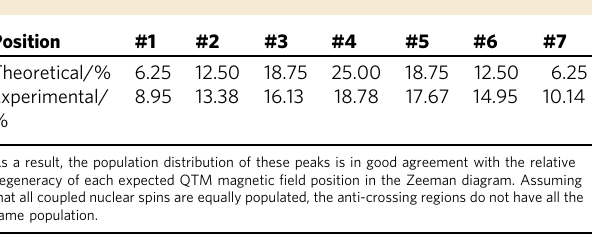
Fig. 3 Electronic read-out of the coupled spin. a Selected differential conductance traces for back-and-forth sweeps highlighting the seven expected tunnelling transitions. b Magnetic hysteresis map as a function of the applied fi eld. The gate voltage V G is fi xed and the source-drain voltage V SD is fi xed to zero. For each value B Y , the differential conductance measured during the back-and-forth magnetic fi eld sweeps are subtracted, and then plotted. Several coloured lines are observed, corresponding to the hysteresis zones of each anisotropic magnetic moment, evolving linearly as a function of the transverse fi eld. The green arrow indicates the studied region. The other regions were also studied but the nuclear spin states could not be resolved. c Histogram of the conductance jumps detected during 6000 magnetic fi eld sweeps. The panel above the Zeeman diagram shows the predicted crossings (enlarged by 20%), showing the correspondence with the experimental observations. d The population histogram is fi tted by seven Gaussian of the same width but different amplitudes, for the seven identi fi ed peaks; and another one with different width and amplitude for the envelope of undetermined events. To ease the interpretation, the jump positions in the histograms have been centred at zero as regard to the central peak. Table 1 Theoretical and experimental QTM probability for Tb 2 Pc 3